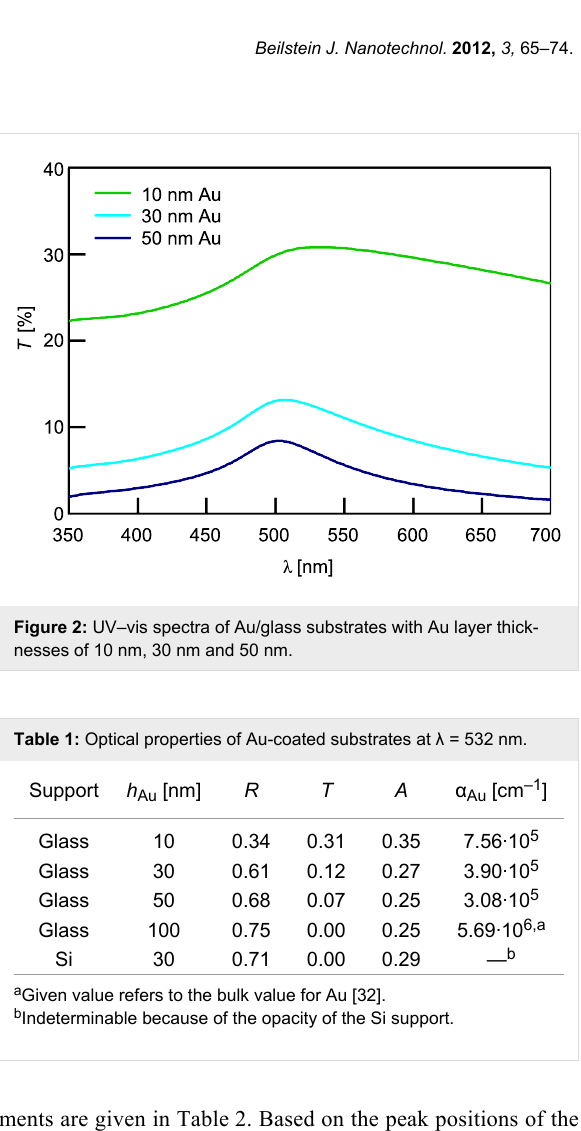
ments are given in Table 2. Based on the peak positions of the antisymmetric methylene stretching vibrations, these data indi- cate densely packed monolayers